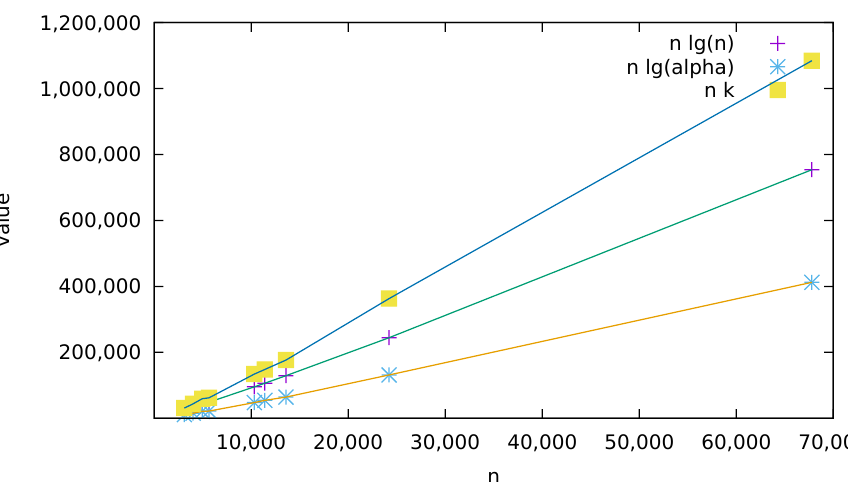
Figure 4. Plots comparing the experimental values of n log n , n log α and nk from the array of Table 3: n log α is roughly half of n log n , itself roughly half of nk .The experimental values of n log n , n log α and nk are all within a constant factor of each